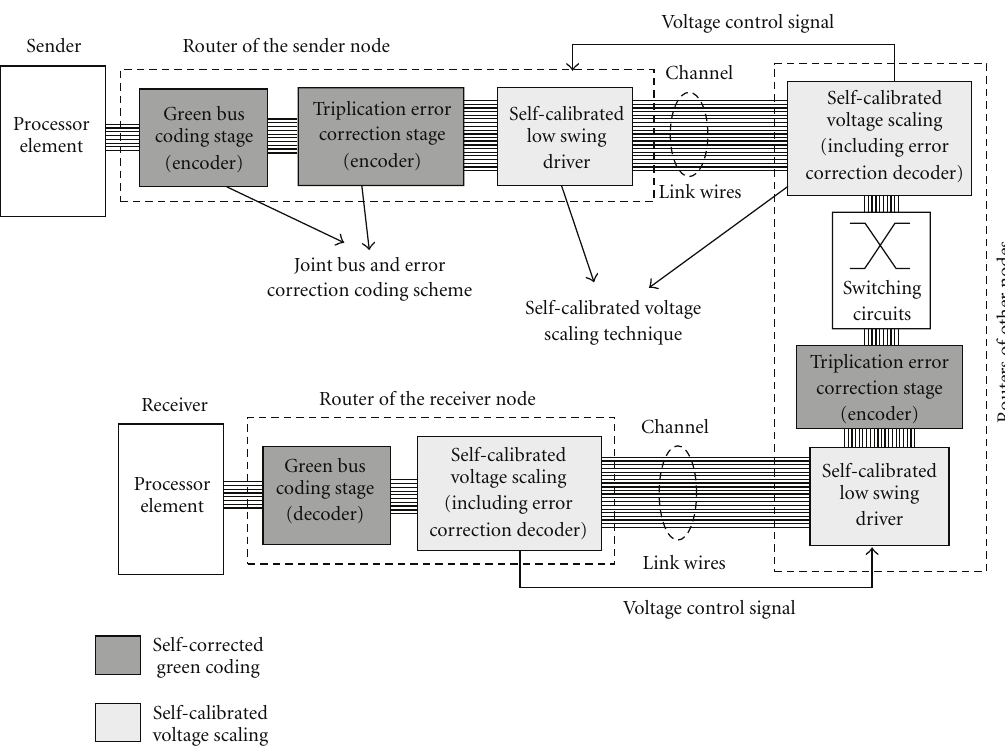
Figure 2: Self-calibrated energy-e ffi cient and reliable channels for on-chip interconnection networks with self-corrected green (SCG) coding scheme and self-calibrated voltage scaling